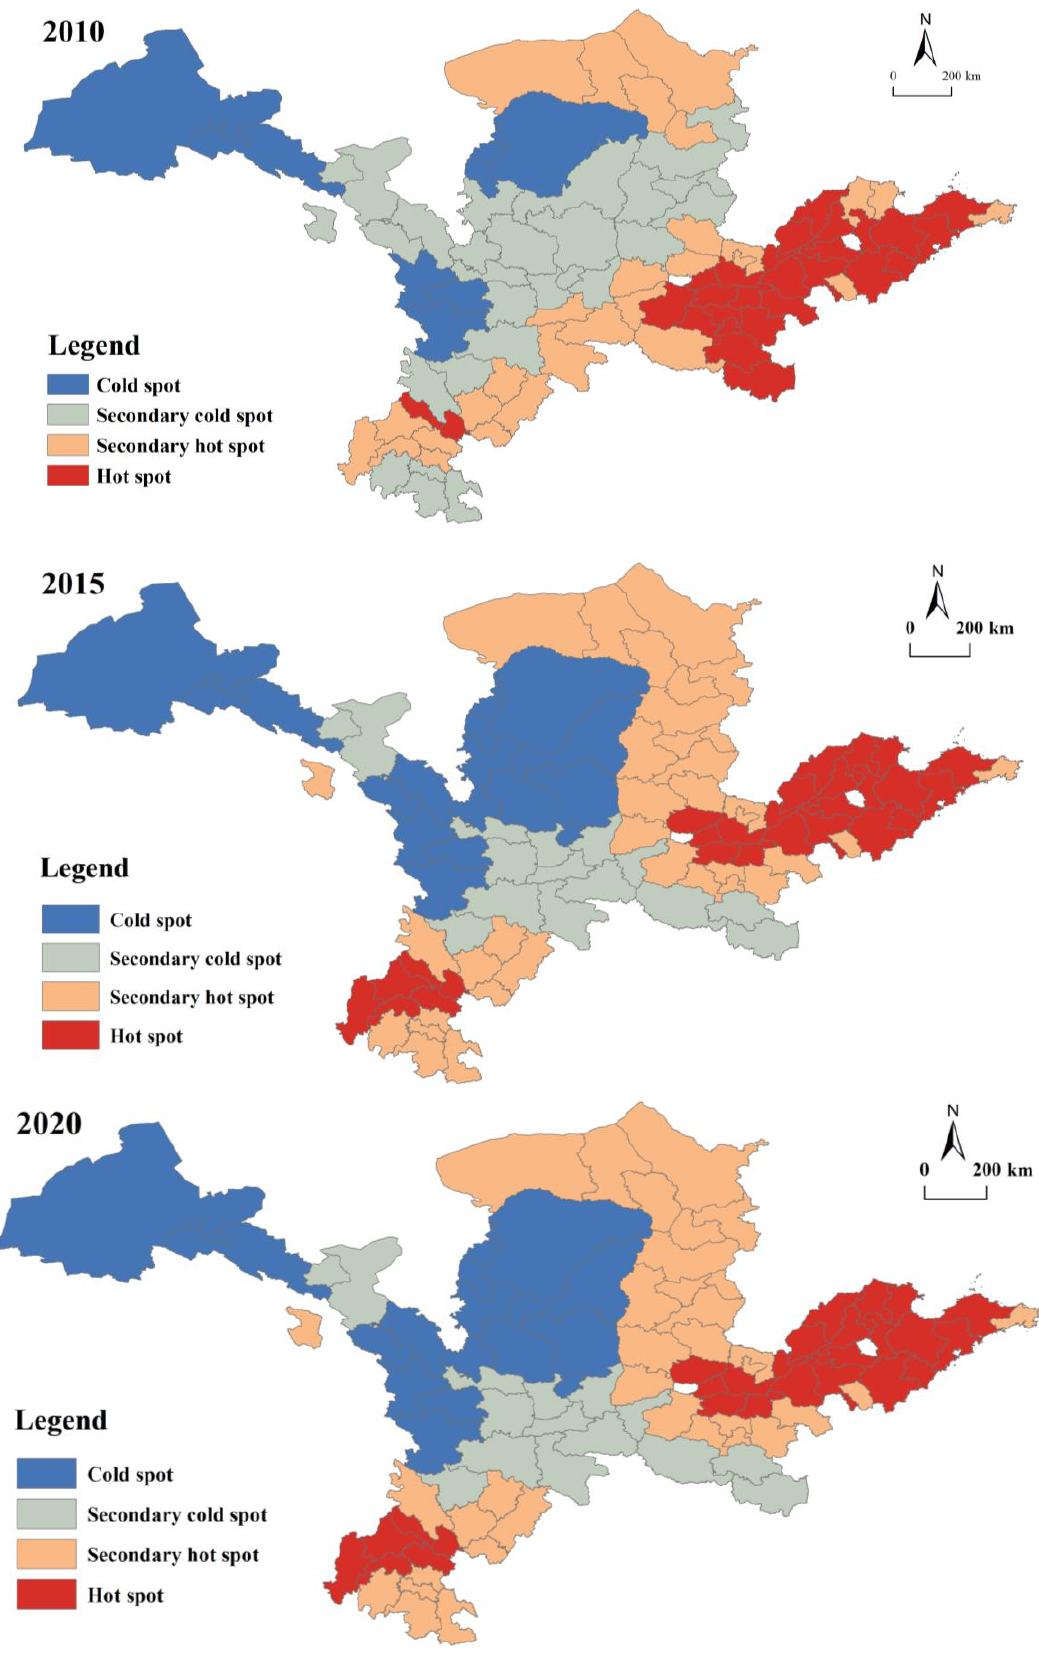
Figure 5. Evolution of cold hotspots of urban‒rural integration .